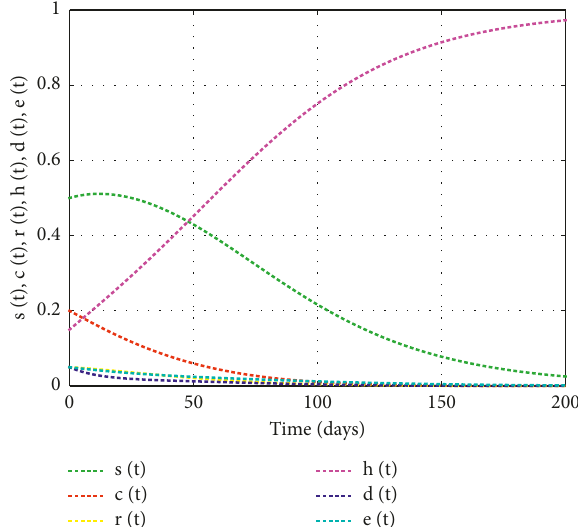
Figure 7: Simulation of population dynamics for R